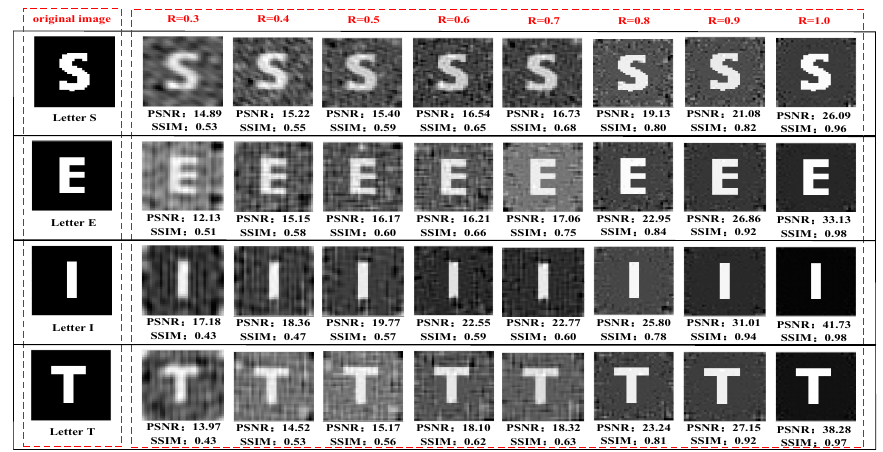
Figure 4. Simulation results: the reconstructed images using atmospheric modulation as the measurement matrix. The first column of the images is the original images (target images); R represents the sampling ratio (M/N).